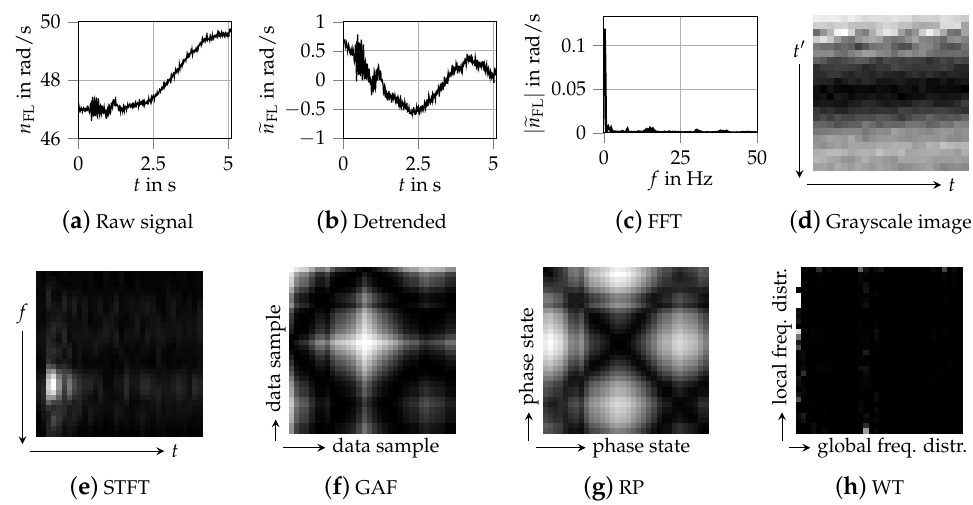
Figure 4. Different pre-processing representations of a data sample of the wheel speed front left n FL .